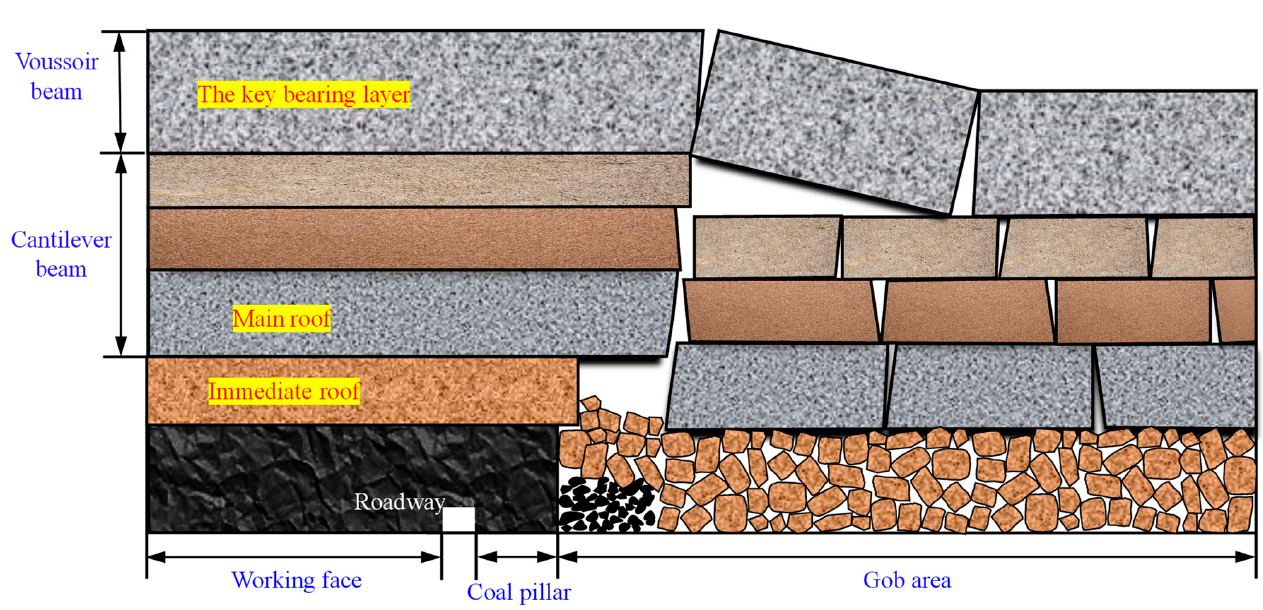
Figure 12. Low-level combined cantilever beam + high-level multilayer masonry beam structure model [50]. model